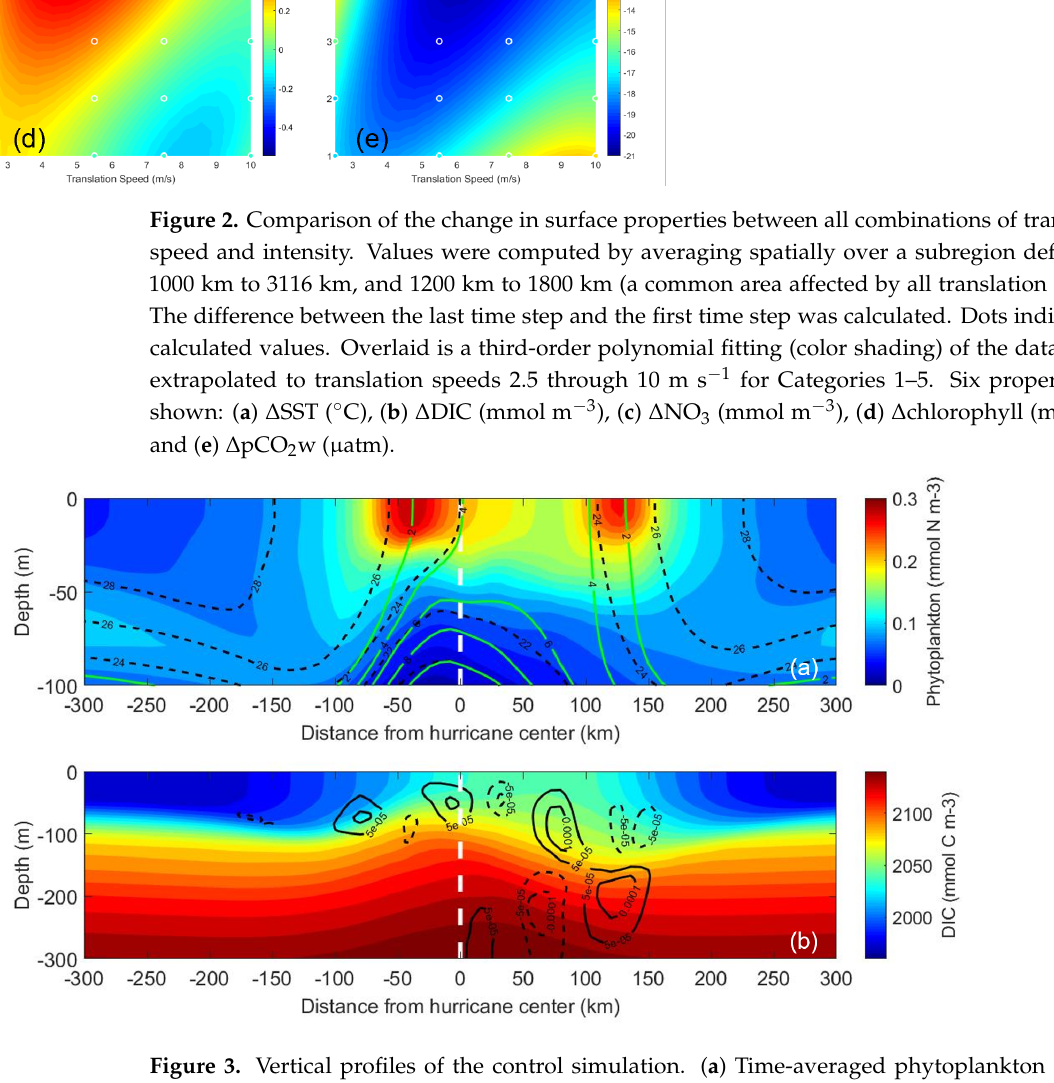
Figure 3. Vertical profiles of the control simulation. ( a ) Time-averaged phytoplankton (colors), temperature (black dashed contours), and nitrate (green contours). ( b ) Time-averaged DIC (colors) and vertical velocity (m s − 1 , black contours; solid lines indicate upward motion, and dashed lines indicate downward motion). All variables have been zonally averaged and time-averaged over three inertial periods. The view is westward in the direction of the translating hurricane, and the white dashed line indicates the hurricane